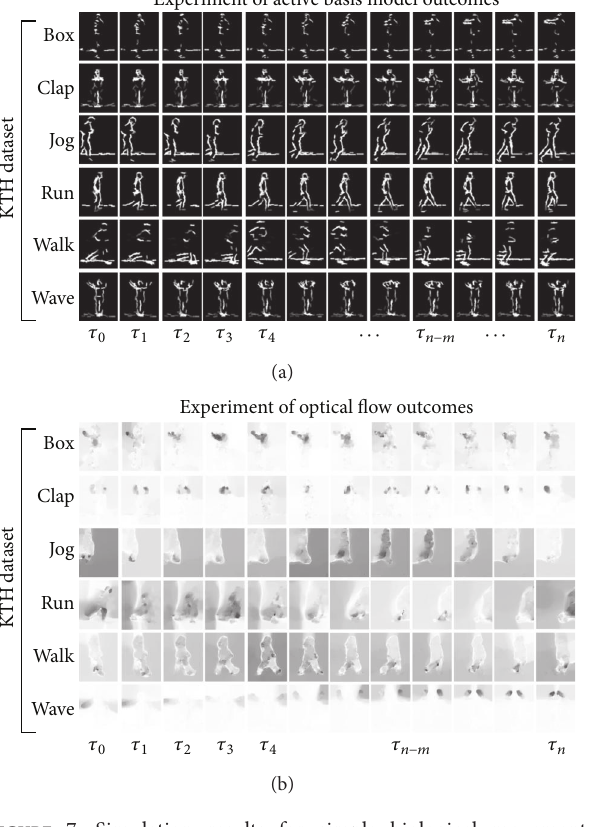
Figure 7: Simulation results for simple biological movement paradigm based on ABM [24] in the ventral processing stream and optical flow [26] in dorsal stream are shown. Each row within the panel reveals the response of ABM during the episode as well as flow generated for every different action. The set of biological movements belongs to the biological movements which is from KTH dataset [39]. (a) The simulation results of the different actions of KTH dataset. (b) Optical flow simulation